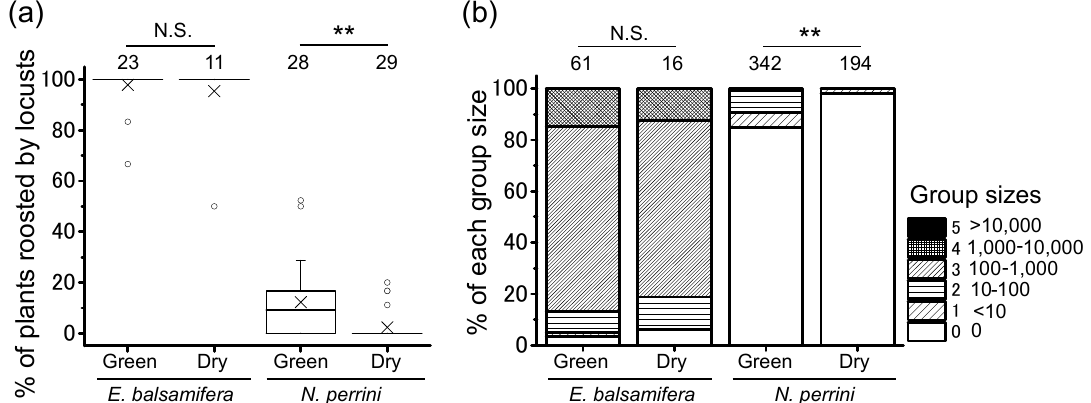
Figure 7. Percentage of green and dry plants roosted by Schistocerca gregaria swarms for Euphorbia balsamifera and Nucularia perrini at Site 1 ( a ) and the percentage of each locust group size on each plant ( b ). Each box plot displays the median value with the ends of the boxes representing the 25th and 75th percentiles and the ends of the lines representing the 10th and 90th percentiles. Crosses indicate mean values and open circles are outliers. Numbers in figures indicate sample sizes. ( a ) **, p < 0.01; N.S. indicates no significant di ff erences between the two groups at p > 0.05 according to a Wilcoxon rank sum test. ( b ) **, p < 0.01; N.S. indicates no significant di ff erences between the two groups at p > 0.05 according to a χ 2